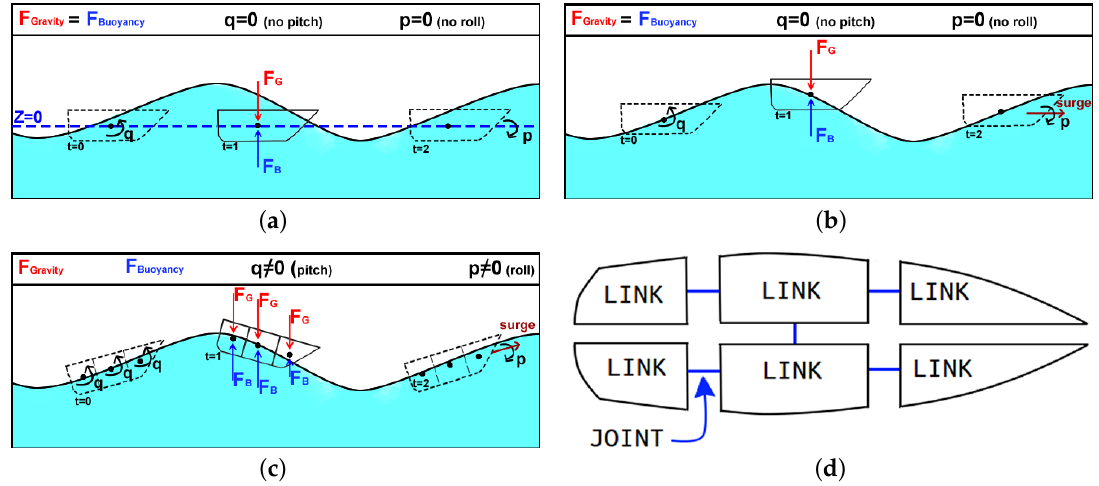
Figure 3. Different implementations of the buoyancy effect are shown in ( a – c ), where black dots represent the center of buoyancy, while red (downward) and blue (upward) arrows represent the gravity and buoyancy force vectors respectively. In ( a ), the buoyancy effect of Freefloating gazebo is shown [21]. In ( b ), we present the buoyancy effect on a boat which takes the wave height into account, given the boat is defined by only one link. In ( c ), a similar effect is shown but the boat is now represented by a set of links and joints subdivided as in ( d ). Note that the gravity and buoyancy forces are applied to each of the links’ center of